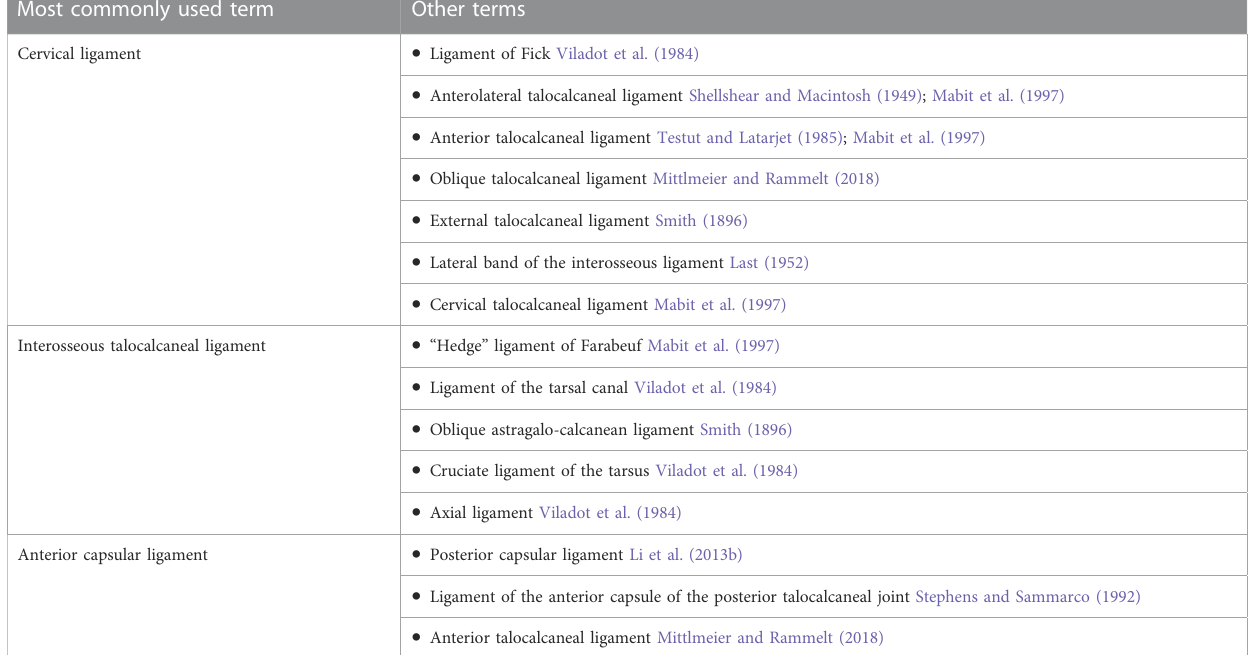
TABLE 1 Terminology used to indicate the subtalar ligaments. Most commonly used term Other terms Cervical ligament